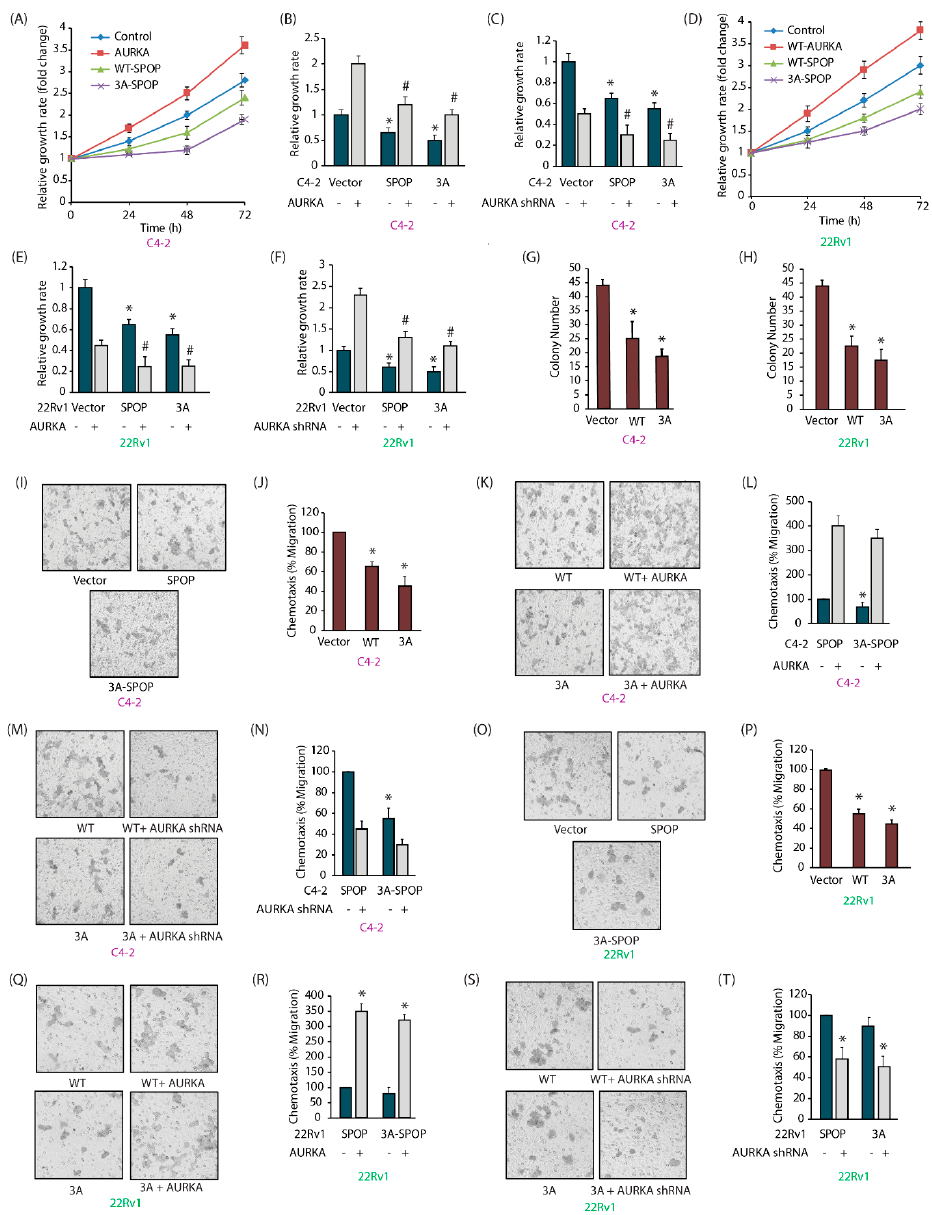
Figure 5. AURKA-mediated phosphorylation of SPOP promotes oncogenic phenotypes. ( A ) SPOP suppresses the proliferation of C4-2 cells. The proliferation of C4-2, AURKA-C4-2, SPOP-C4-2 and 3A-SPOP-C4-2 cells at 24 h, 48 h and 72 h was evaluated by MTT assay. ( B ) Impact of AURKA overexpression on the cell proliferation in C4-2, SPOP-C4-2 and 3A-SPOP-C4-2 cells. * and # indicate statistically significant differences compared to respective controls; p < 0.05. ( C ) AURKA knockdown diminished cell growth in C4-2, SPOP-C4-2 and 3A-SPOP-C4-2 cells. * and # indicate statistically significant difference compared to respective controls; p < 0.05. ( D ) Decrease in cell proliferation with SPOP overexpression in 22Rv1 cells. 22Rv1, AURKA-22Rv1, SPOP-22Rv1 and 3A-SPOP-22Rv1 cells were cultured for 24 h, 48 h, and 72 h and subjected to MTT assay. ( E ) AURKA overexpression enhances cell proliferation in 22Rv1, SPOP-22Rv1 and 3A-SPOP-22Rv1 cells. * and # indicate